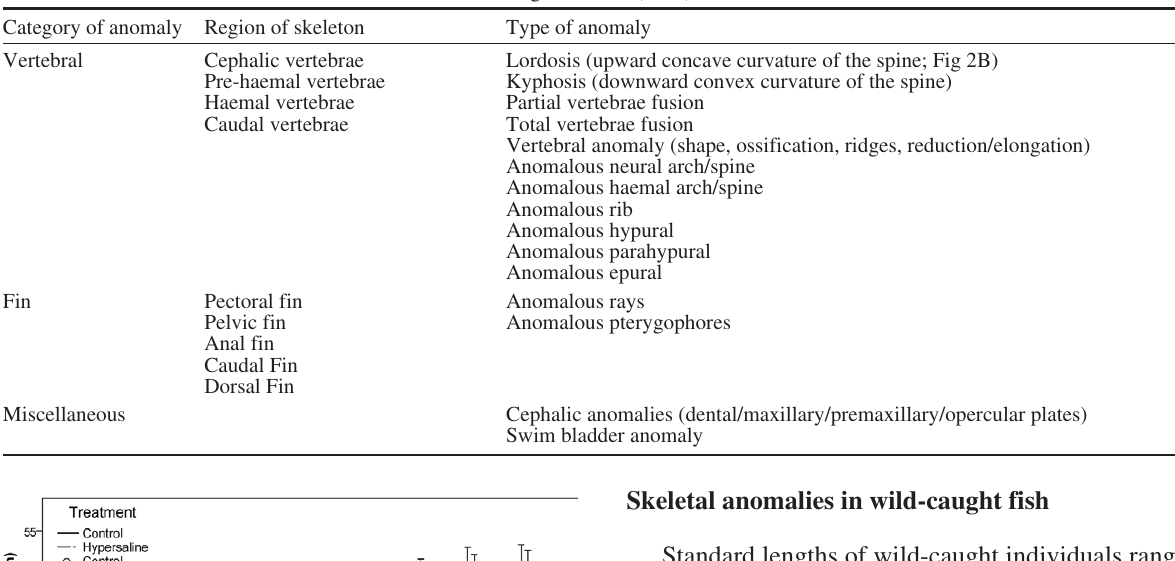
Table 1. – List of skeletal anomalies considered for analysis of Rhabdosargus holubi juveniles grown in different conditions, adapted from Boglione et al. (2001).